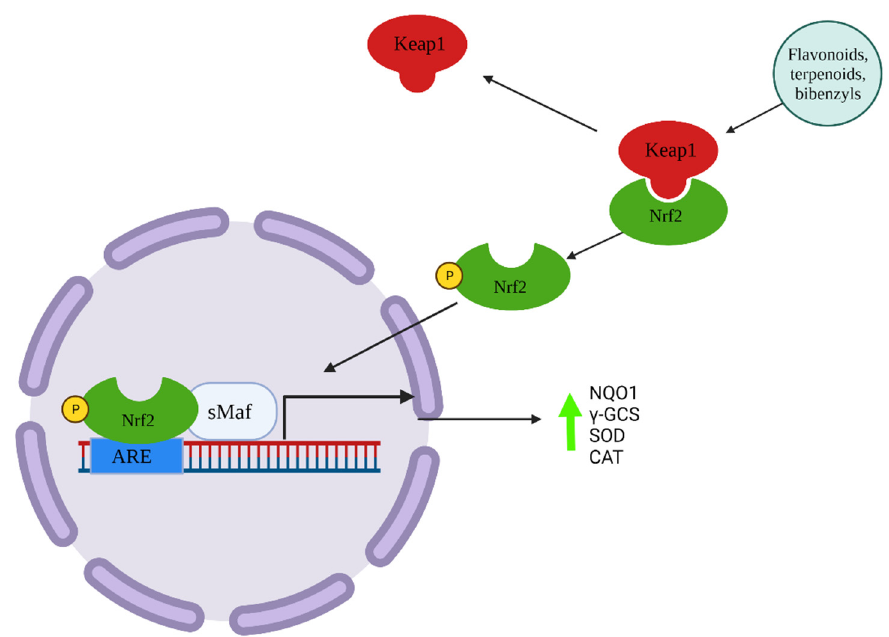
Figure 2. Schematization of indirect induction of cytoprotective proteins through Keap1/Nrf2/ARE system by antioxidant compounds .